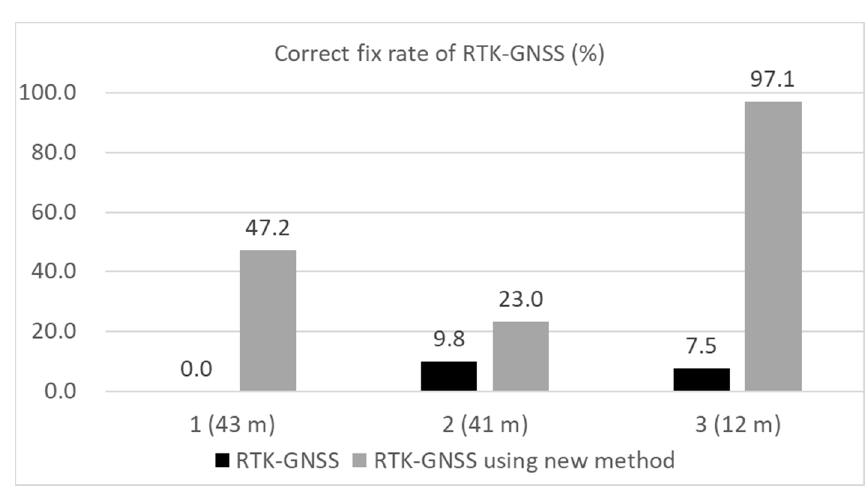
Figure 23. Comparison of RTK-GNSS correct fix rates in three locations.